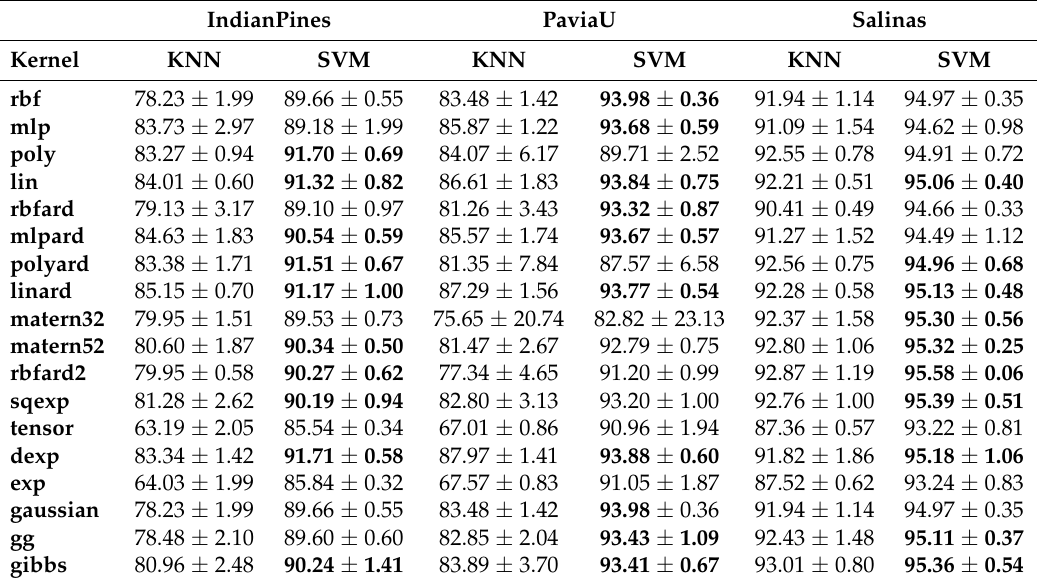
Table 3. Classification accuracy based on the proposed GPGDA with 18 kernels on Indian Pines, University of Pavia and Salinas